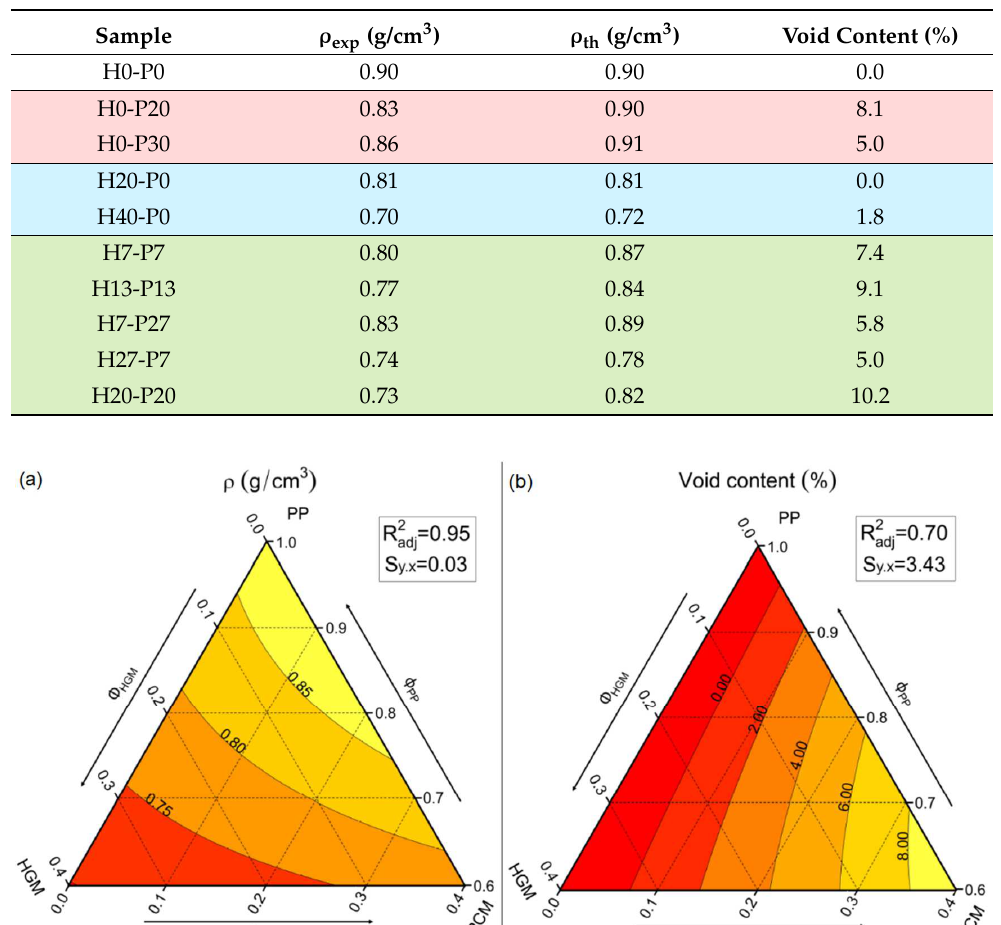
Figure 3. Viscosity (η) as a function of the shear rate ( prepared foams.